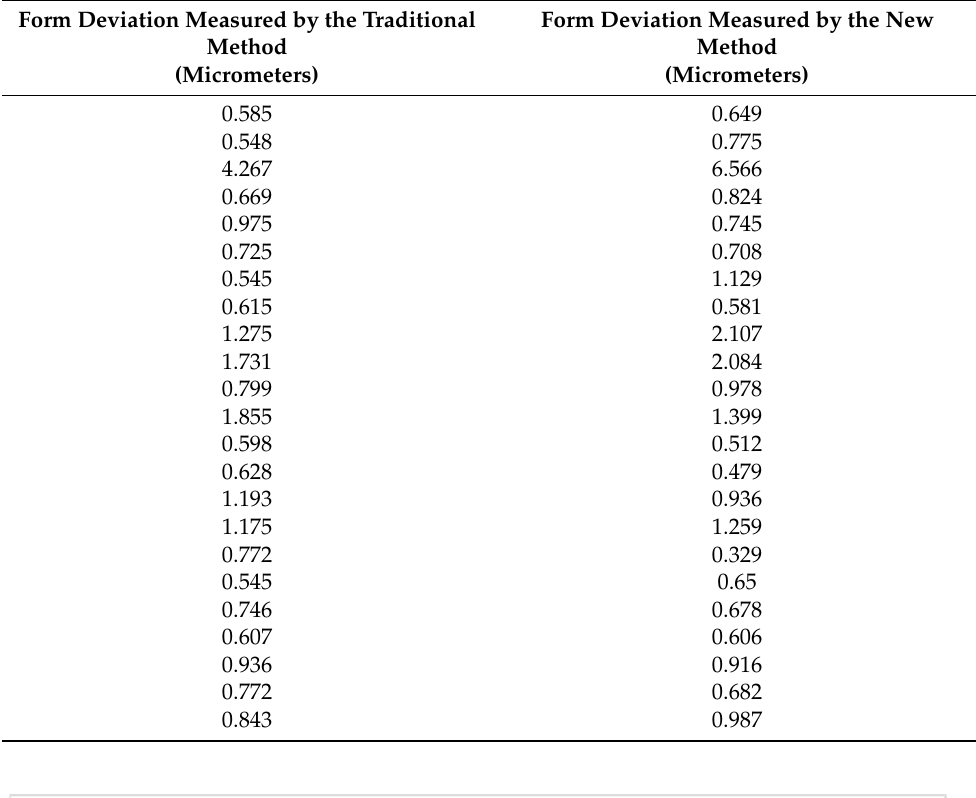
Table 2. Measurement results for the second set of parts.